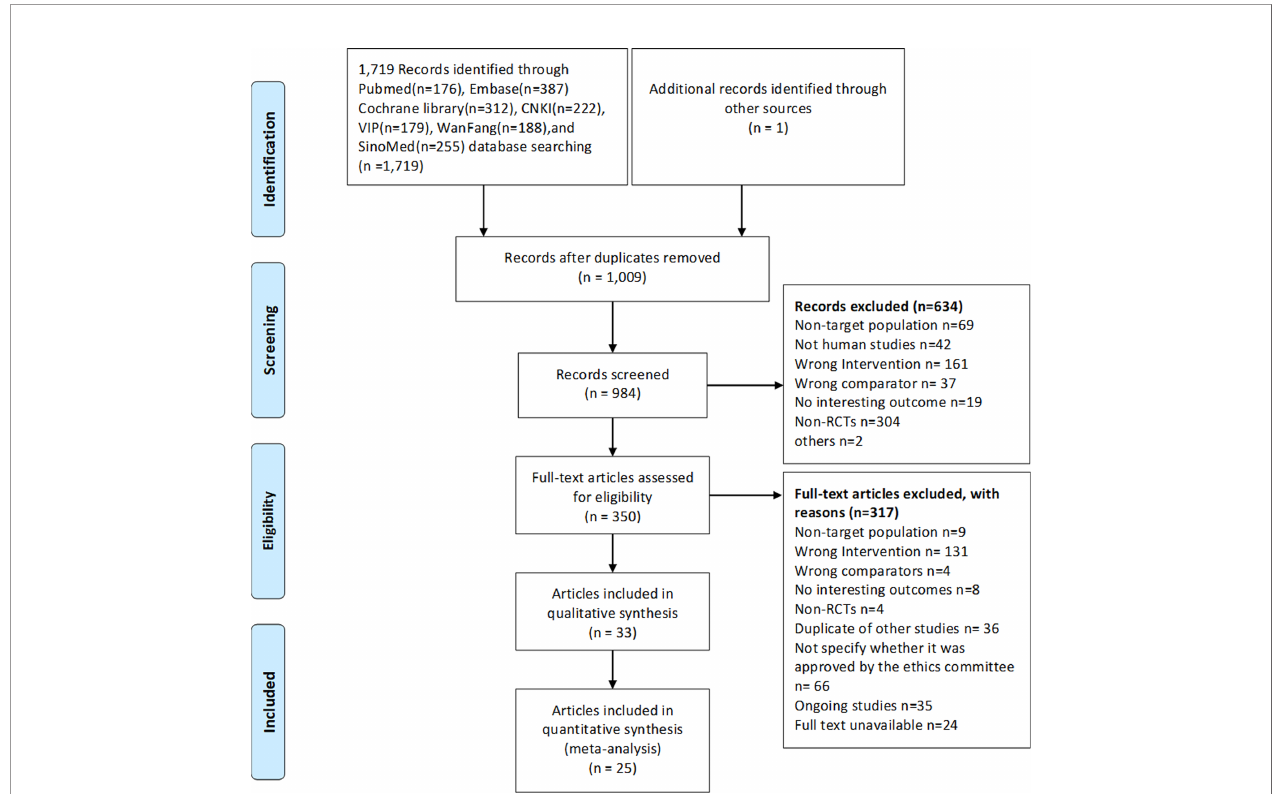
FIGURE 1 | The PRISMA 2009 fl ow diagram for literature screening. RCTs randomized controlled